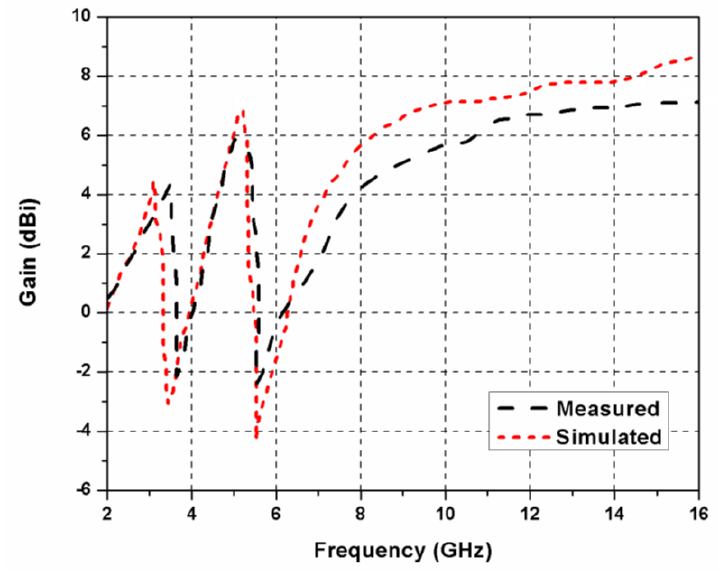
Figure 9. Simulated and measured gain of the proposed antenna.